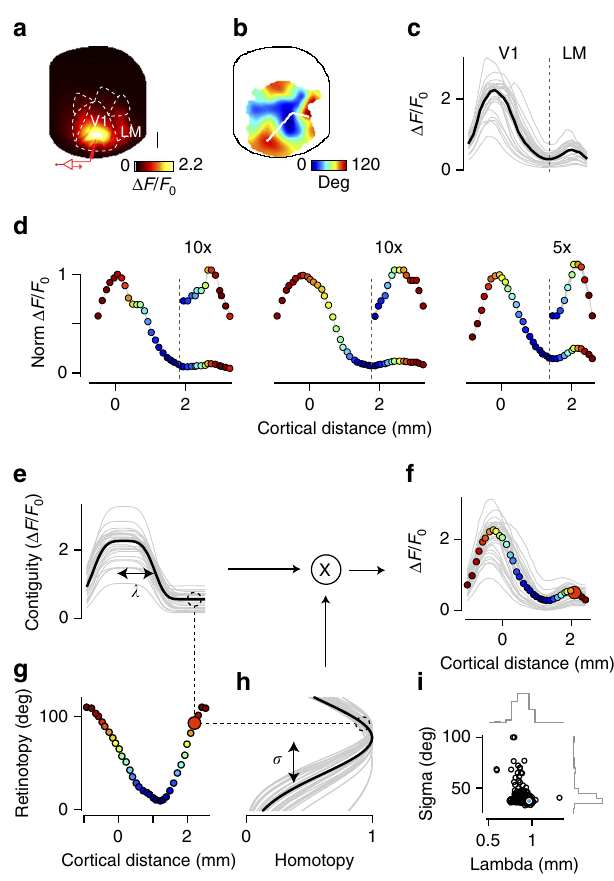
Fig. 4 Interictal events and early seizures engage both contiguous spread and homotopic connectivity. a Average spatial pro fi le of interictal events measured in one mouse, obtained by averaging the maximum projection map across events ( n = 242). The cartoon electrode indicates the site of Ptx injection and LFP recording. Scale bar is 1 mm. b Map of retinotopy (preferred horizontal position) with a line from the focus in V1 to area LM, joining regions of interest (ROIs) with same preferred vertical position as the focus in V1. c Peak Δ F / F 0 response at each ROI in b for a representative interictal event ( black ) and for 30 other interictal events ( gray ). d The spatial pro fi le averaged across interictal events for three representative animals (two measured with GCaMP3 and the third with GCaMP6), along lines drawn with the same strategy as in b . Dot color indicates the retinotopic preference of the corresponding location. Insets show the magni fi ed pro fi le of responses in area LM. The very thin gray shaded line represents mean ± s.e.m. e – h The bimodal pro fi le of activity for each interictal event is well described by the dot product of a function of cortical distance from the focus e , and a function of retinotopic distance from the focus h . Dotted lines illustrate how the model predicts the second peak of activation ~2 mm away from the focus f , due to the similar retinotopic preference of that region and the focus g . i Distribution of fi t parameters for the example animal, indicating a consistent role of contiguous spread and homotopic connectivity across